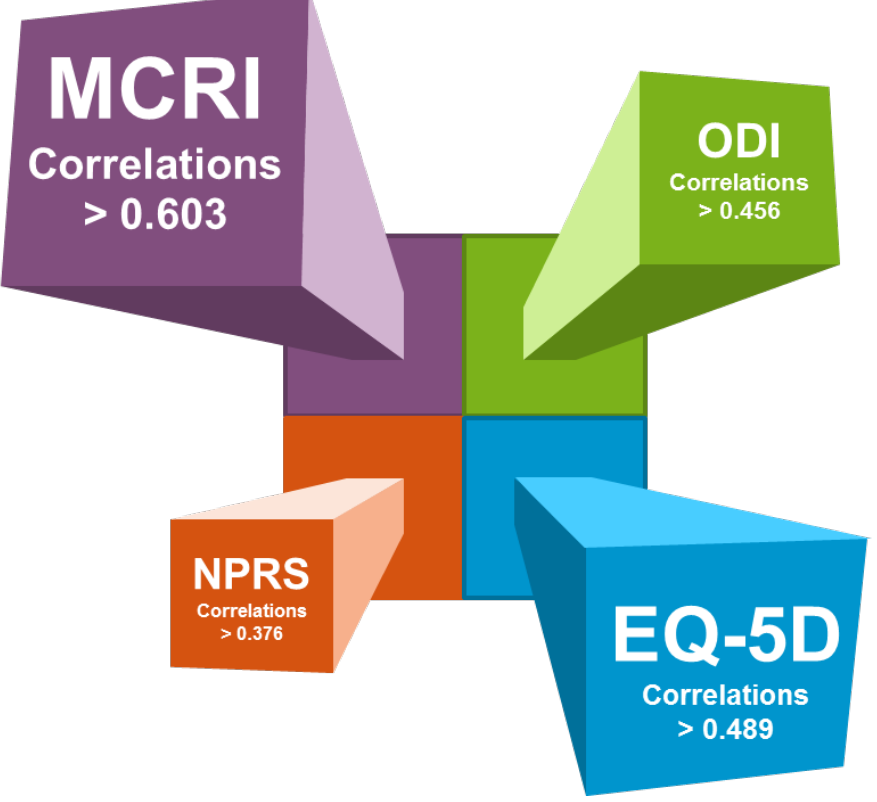
Figure 4. An illustrative representation of the top 4 correlations reflecting pain dimensions.